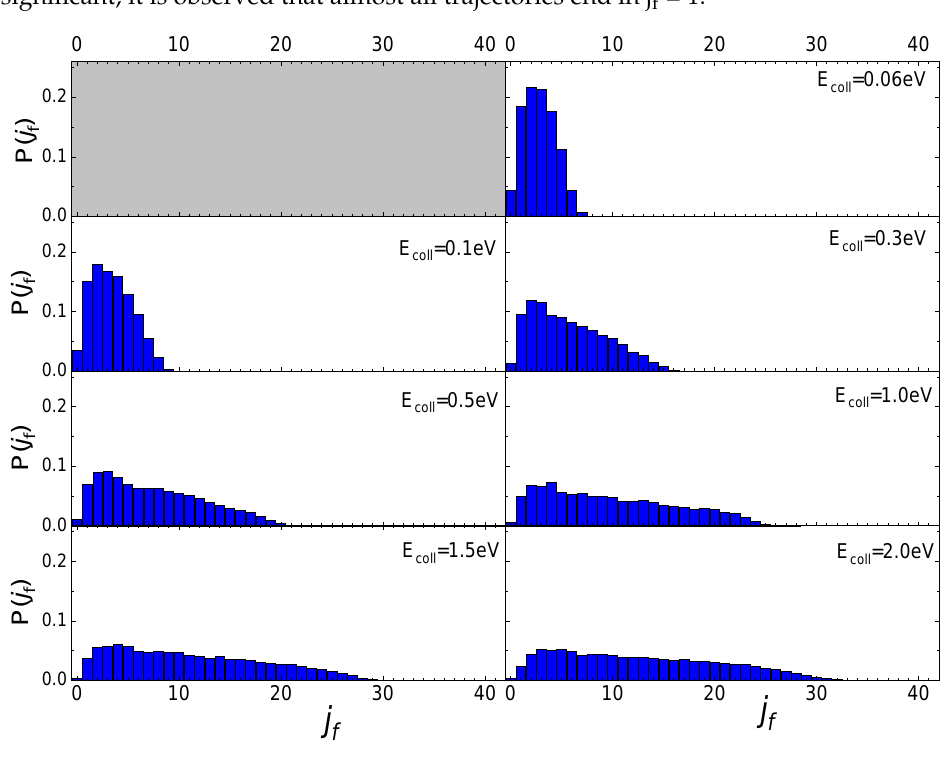
Figure 5. Final rotational distributions for N 2 (0,0) molecules scattered by quartz surface. T S = 100 K.